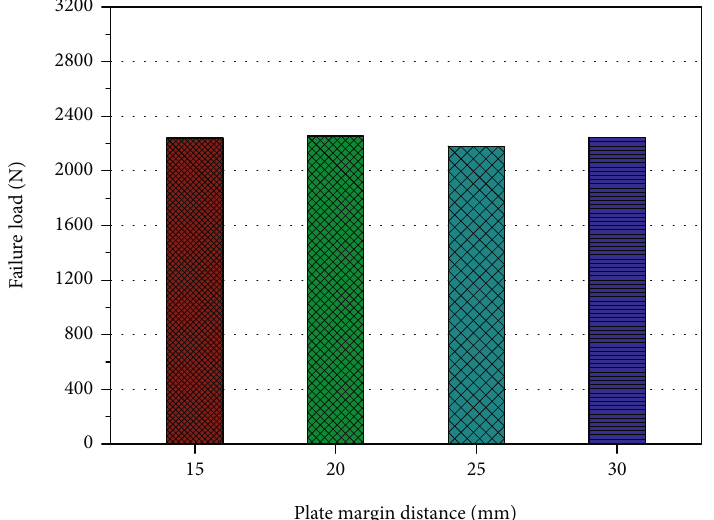
Figure 12: Variation of the failure load with plate margin distance for the studied CMC/superalloy double bolted joint at 750 °